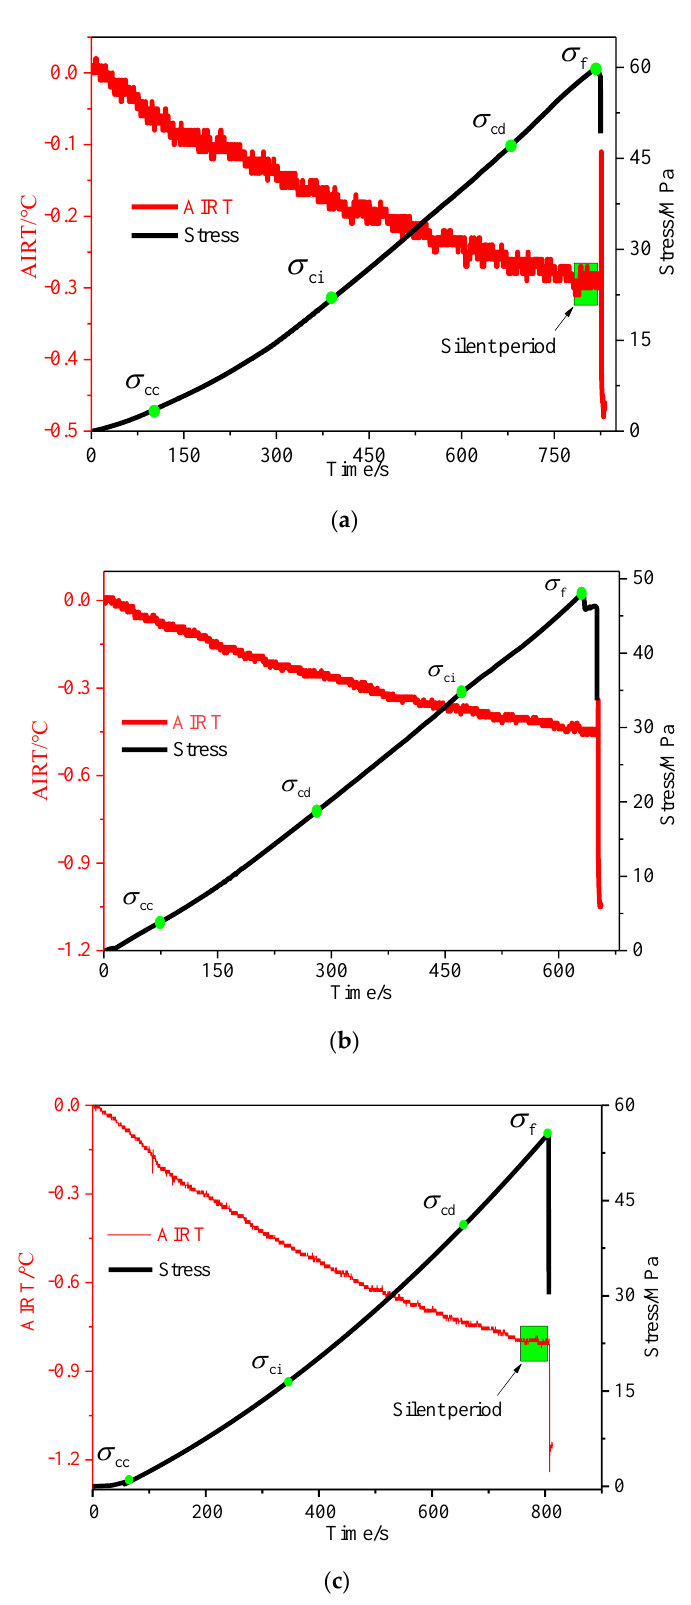
Figure 6. Decreasing AIRT variations of sandstone samples. ( a ) Sandstone A 1. ( b ) Sandstone A 6. ( c ) Sandstone A 9.